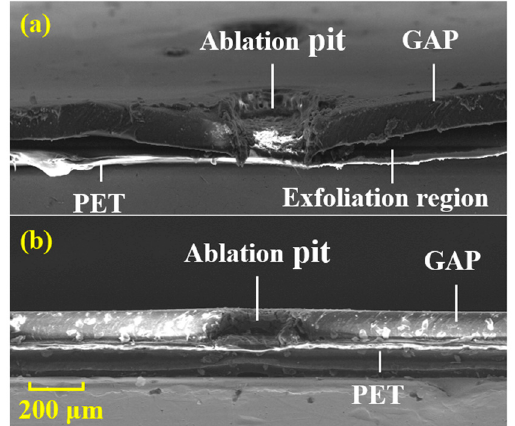
Figure 8. The separation phenomenon of the tape pre- and post-plasma treatment. ( a ) The tape without plasma treatment; ( b ) The tape with plasma treatment.